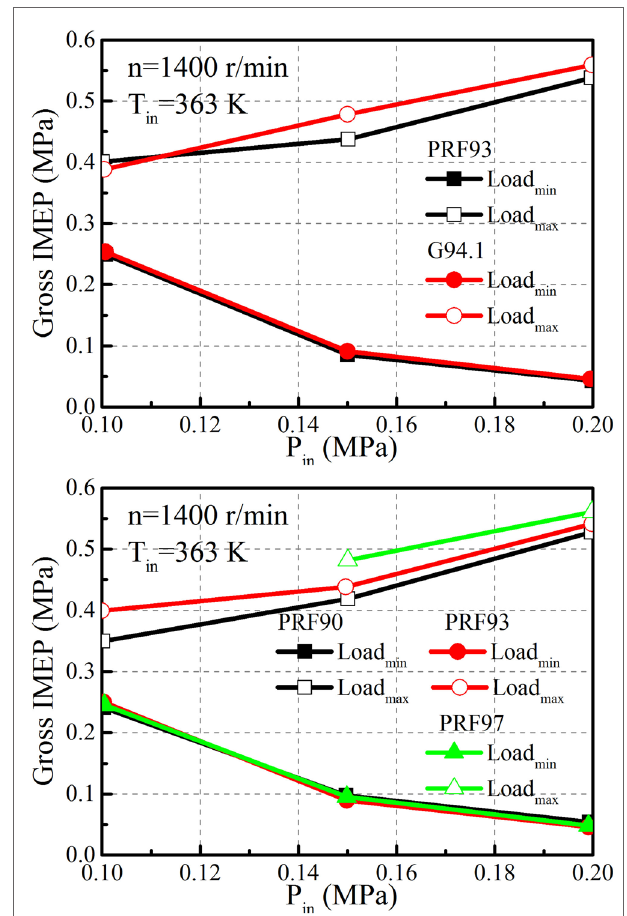
FiGURe 1 | effects of boost pressure and RON on single fuel HCCi operating ranges